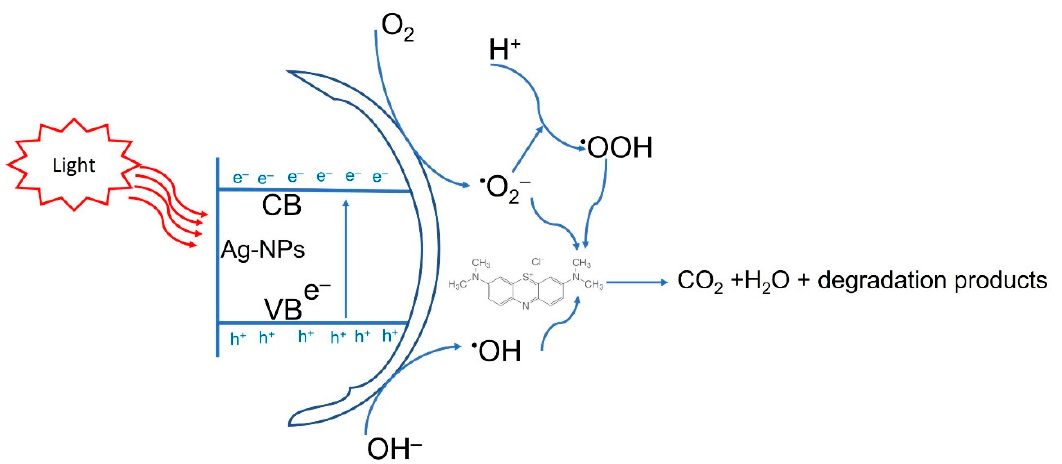
Figure 8. Prospective photocatalytic degradation mechanism of methylene blue using green synthe- sized Ag-NPs.